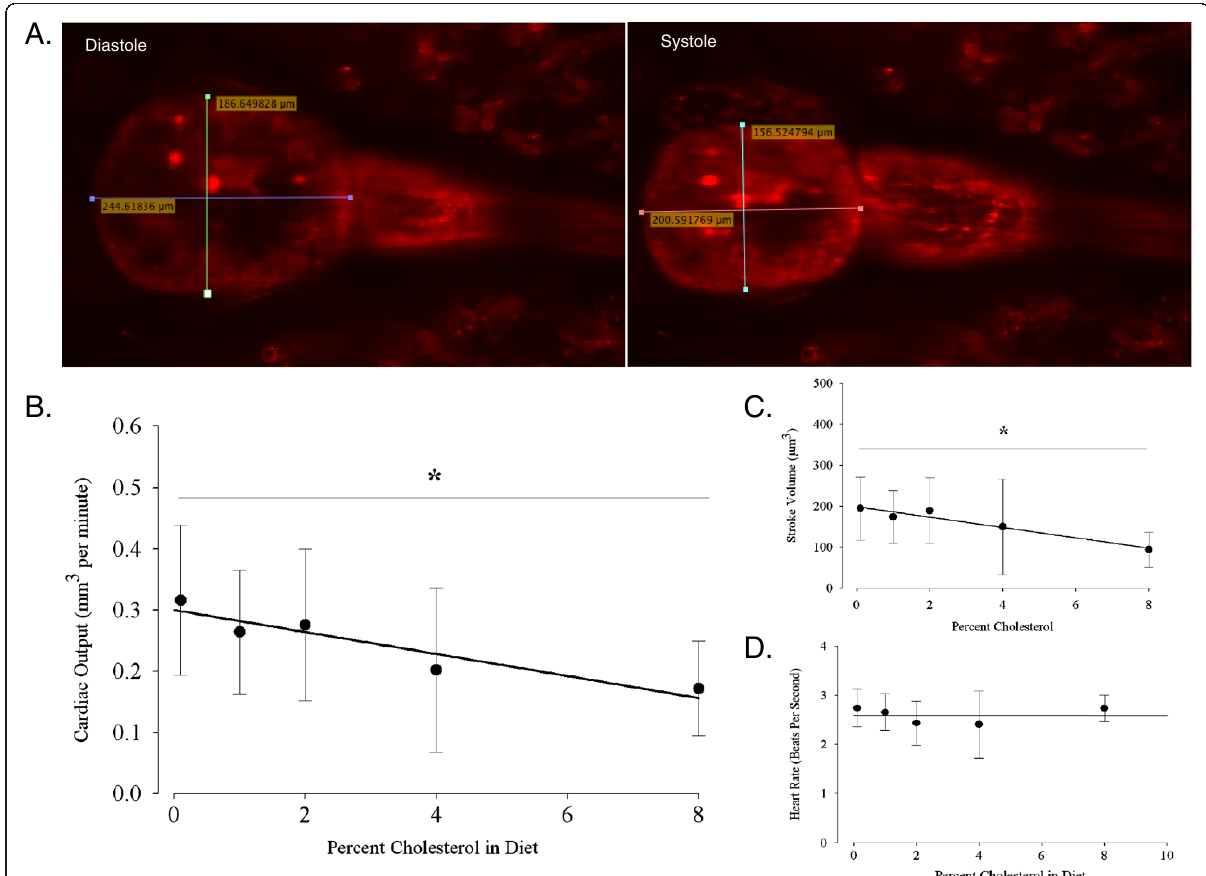
Figure 3 Cardiac Output (CO) Decreases with Increasing Cholesterol (CH) Dose. A . Measurement of ventricular diastole and systole in TG (Kdrl:mCherry)/Casper transgenic to derive stroke volume (SV) in order to finally calculate CO B . CO decreases with increasing CH dose from 0.1-8% HCD (R=0.397, R 2 =0.158). Difference between 0.1% and 8%HCD effect on CO is significant C. SV also decreases with increasing CH dose from 0.1-8%HCD (R=0.396, R 2 =0.157). Difference between 0.1% and 8%HCD effect on SV is significant C. There is not a relationship between HR and CH dose. * P<0.05, points are mean±S.D. 1-way ANOVA, Holm-Sidak post-hoc analysis. n=12-13 per